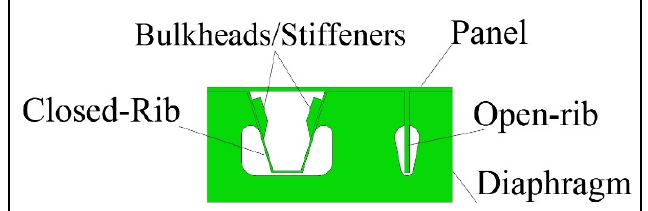
Figure 2. Typical diaphragm for open- and closed-rib sections.